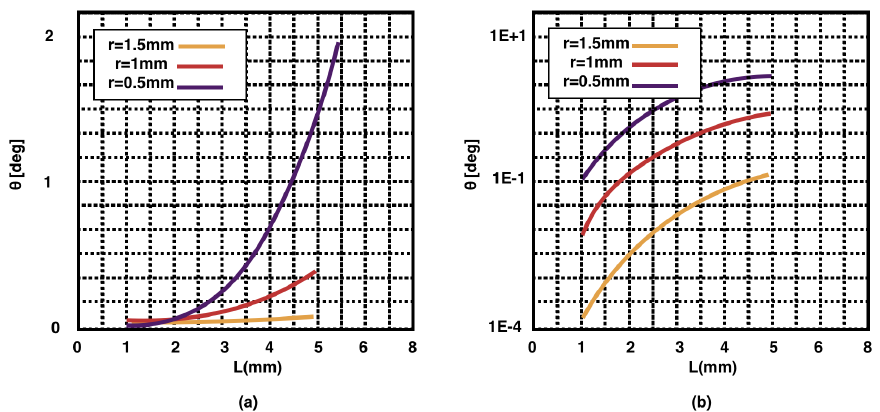
Figure 6. ( a ) Variation of stretch angle with clutch length under 2 Nm maximum torque, ( b ) Variation of stretch angle with clutch length under 2 Nm maximum torque (logarithmic).